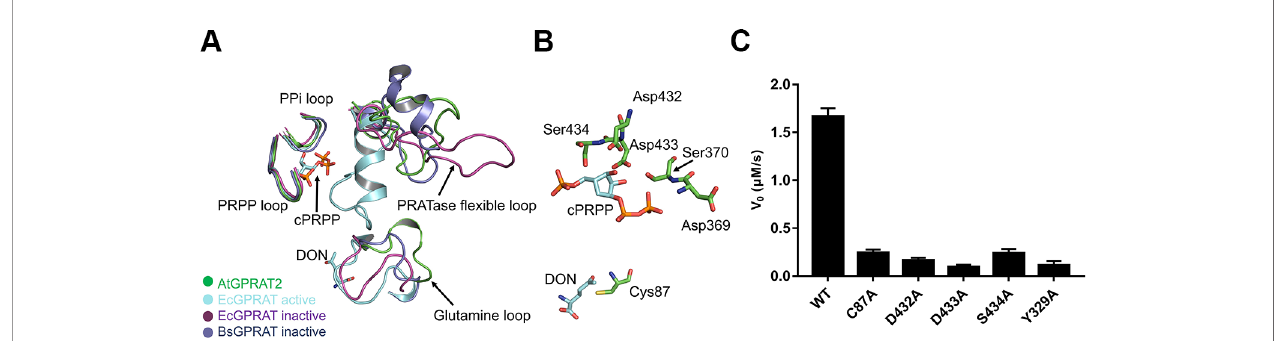
FIGURE 2 | Active site of AtGPRAT2. (A) Structural superimposition of AtGPRAT2, EcGPRAT in the active [Protein Data Bank (PDB): 1ECC] and inactive (PDB: 1ECF) conformation, and Bacillus subtilis glutamine phosphoribosylpyrophosphate amidotransferase (BsGPRAT) in the inactive conformation (PDB: 1GPH). Only the indicated loop regions are shown in cartoon models. The ligands in 1ECC are shown as sticks. cPRPP, carbocyclic phosphoribosyl pyrophosphate (PRPP). DON, 6- diazo-5-oxo-L- nor -leucine, is an analog of substrate glutamine. The conserved loop regions are marked. (B) An enlarged view of the active site of AtGPRAT2. Several active site residues (green) and the substrate analogs cPRPP and DON in the aligned structure of EcGPRAT in the active conformation (PDB: 1ECC) are shown in sticks. (C) Activity assay with the wildtype and several active site mutants of AtGPRAT2. Error bars are standard error of the mean (SEM) values of three independent